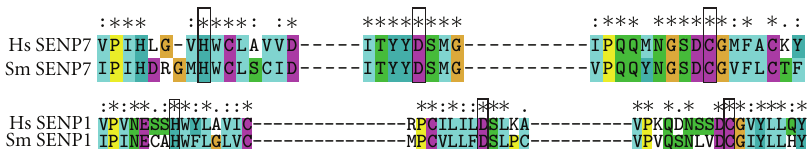
Figure 2: S. mansoni has two predicted SUMO-Specific Proteases. ClustalX 2.0 alignment of SENP1 and SENP7 catalytic residues from human and S. mansoni . The domains position of proteins in S. mansoni were based on Pfam database as well as the e -value score. The grey boxes represent the conserved domains based on Pfam database. Aligned catalytic residues are denoted by the black box. ∗ , :, and . indicate, respectively, identical residues, highly conserved amino acid substitution, and conserved amino acid substitution.